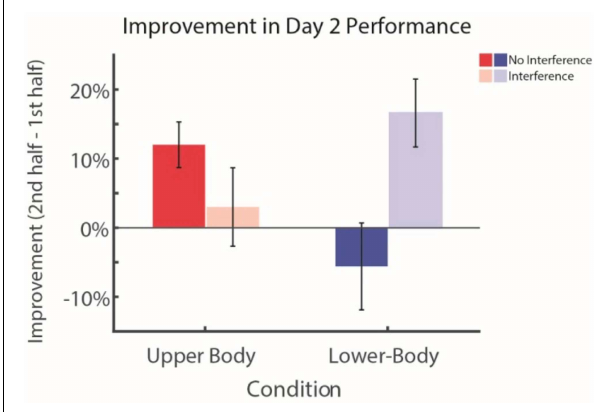
FIGURE 3 | Effects of interference in long-term visual search performance and learning. Subjects who perform the interference task (Experiment 3) demonstrate significant improvement during the course of Day 2 for the novel lower-body visual search task. In contrast, subjects who do not perform the interference task (Experiment 2) demonstrate a significant decrease in learning on the novel lower-body search task, both when compared to their own improvement on the familiar upper-body search as well as in comparison to the learning of the interference group during lower-body visual search. Error bars represent ± 1 SEM